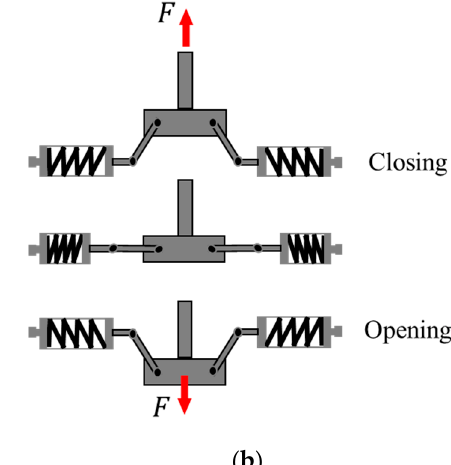
Figure 6. Schematic of di-stable spring mechanism: ( a ) redrawn as depicted in [71]; ( b ) Bi-stable spring working principle.